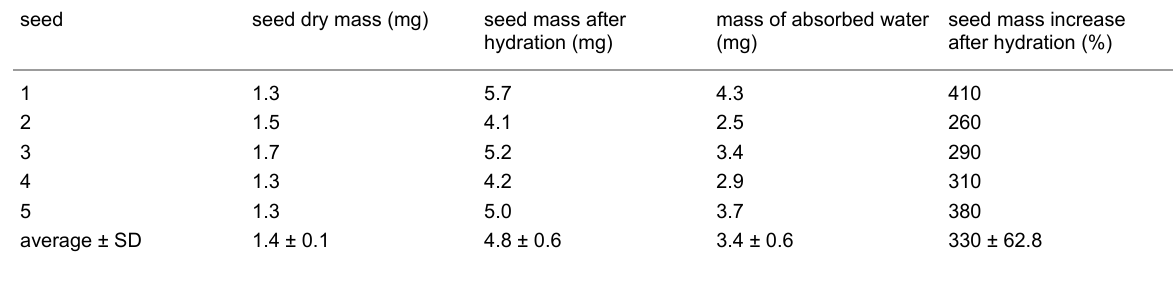
Table 1: The mass of Plantago lanceolata seeds before and after hydration. seed